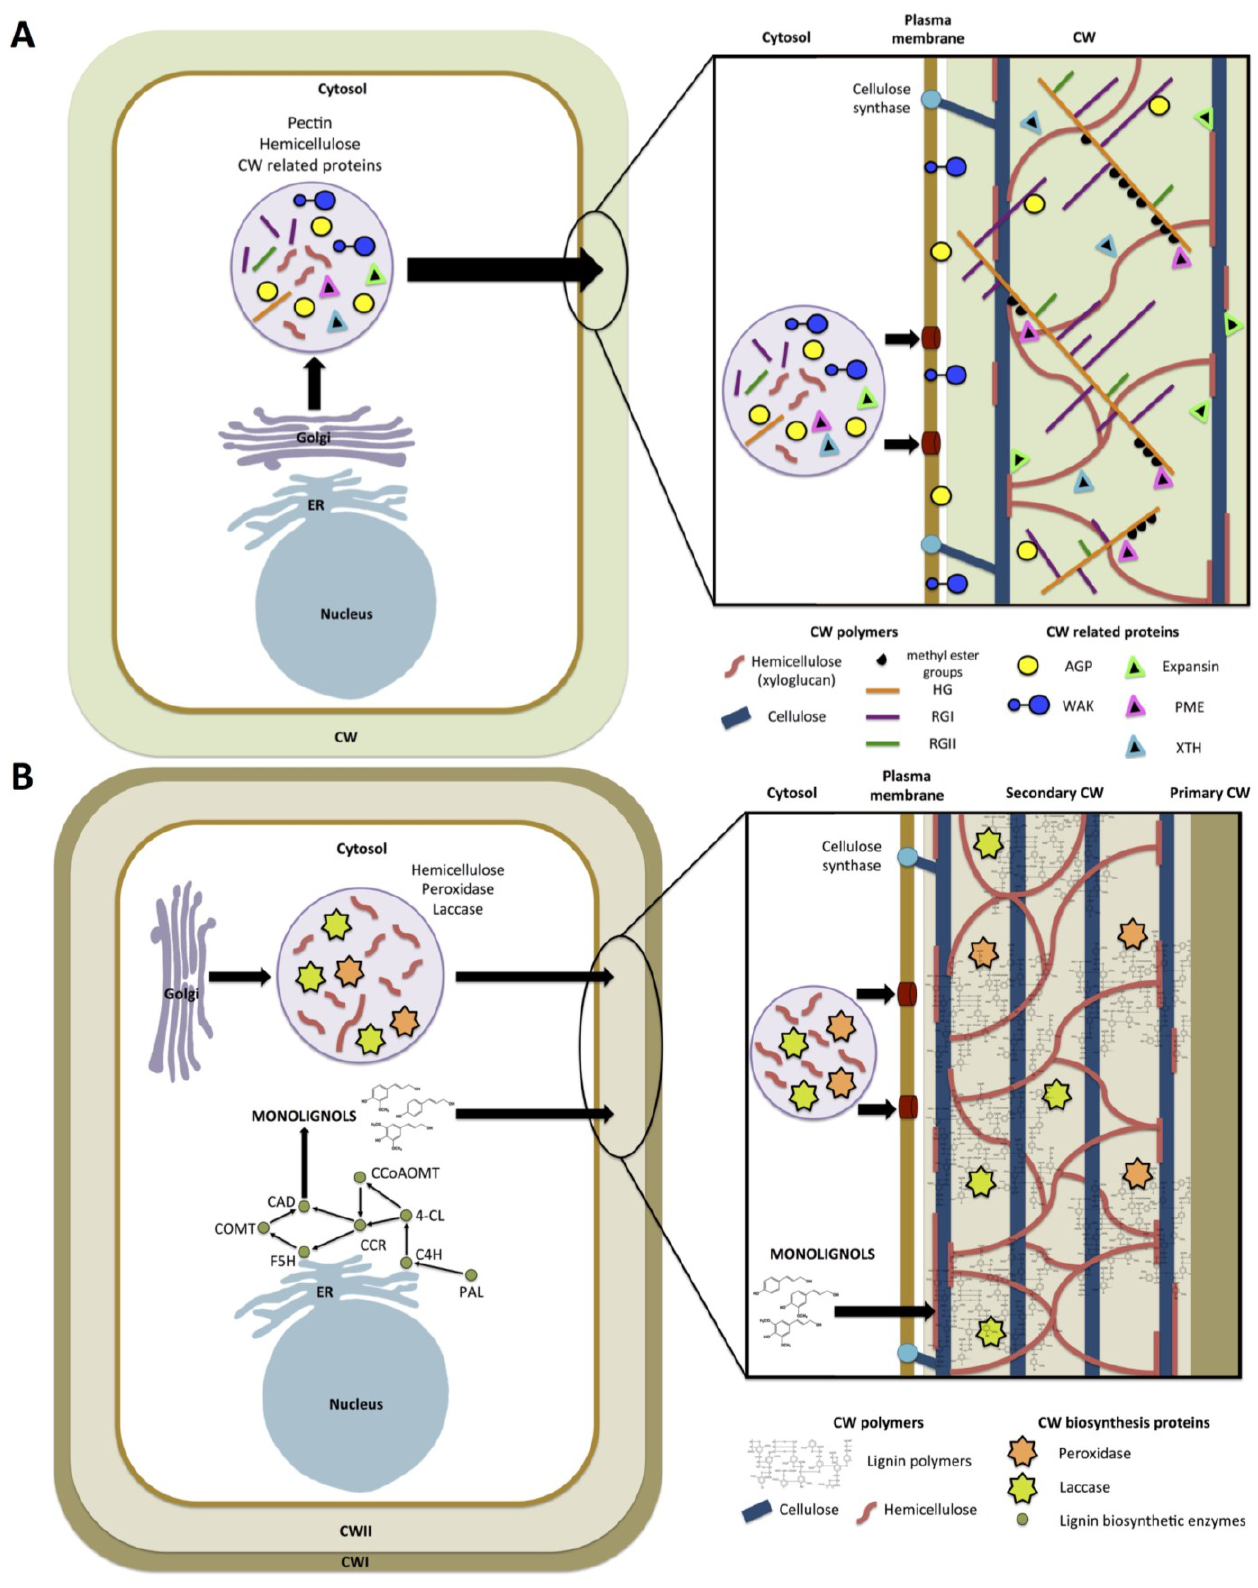
Figure 10. Model depicting changes in the plant cell wall mechanism in response to abiotic stress. ( A ) Key points of the dynamics of type I primary cell wall (CW) during abiotic stress exposure are shown. Cell wall polymer biosynthesis takes place at different locations within the cell. During cell wall formation, hemicelluloses and pectin are synthesized in the